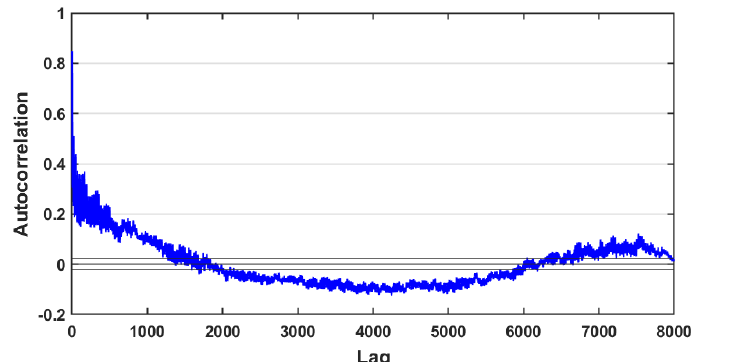
Figure 2. Autocorrelation coefficient with respect to different time-lags. On the graph, the value of the autocorrelation function for each lag is plotted. In or- der to capture the correlation of observations on the current status, the autocorrelation coefficient function is plotted for 24 h and 168 h (one week) as shown in Figure